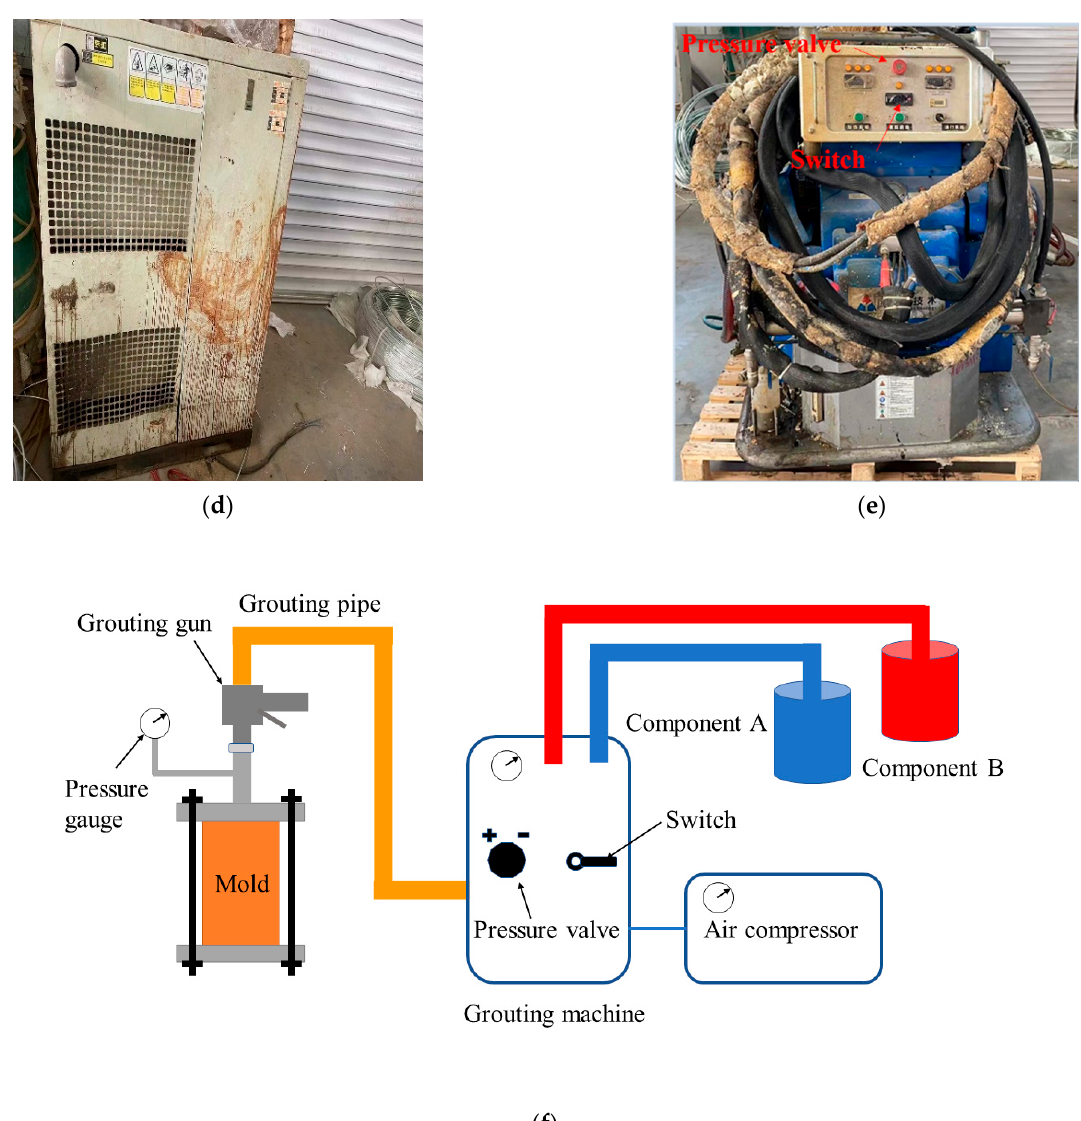
Figure 3. The physical and schematic diagram of the grouting system. ( a ) Sealing rubber gasket, ( b ) Mold, ( c ) Grouting pipe and grouting gun, ( d ) Air compressor, ( e ) Grouting machine, ( f ) Schematic diagram of grouting system.